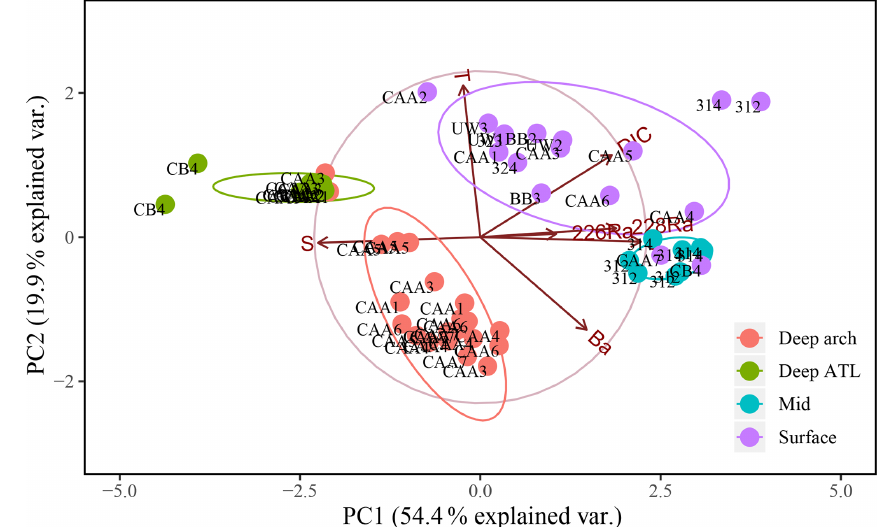
Figure 10. Principal component analysis (PCA) of PC1 and PC2 for 64 samples from 17 stations throughout the Canadian Arctic Archipelago, composed of the seven transformed and normalized variables: salinity ( S P ), temperature ( T ), DIC, Ba, δ 18 O, 228 Ra, and 226 Ra, excluding AT. They are distinguished by depth groupings: surface (0–20m; purple), mid (20–80m; blue), and deep archipelago (deep arch, 80–500m; red), and deep Atlantic (deep ATL, > 500m; green).